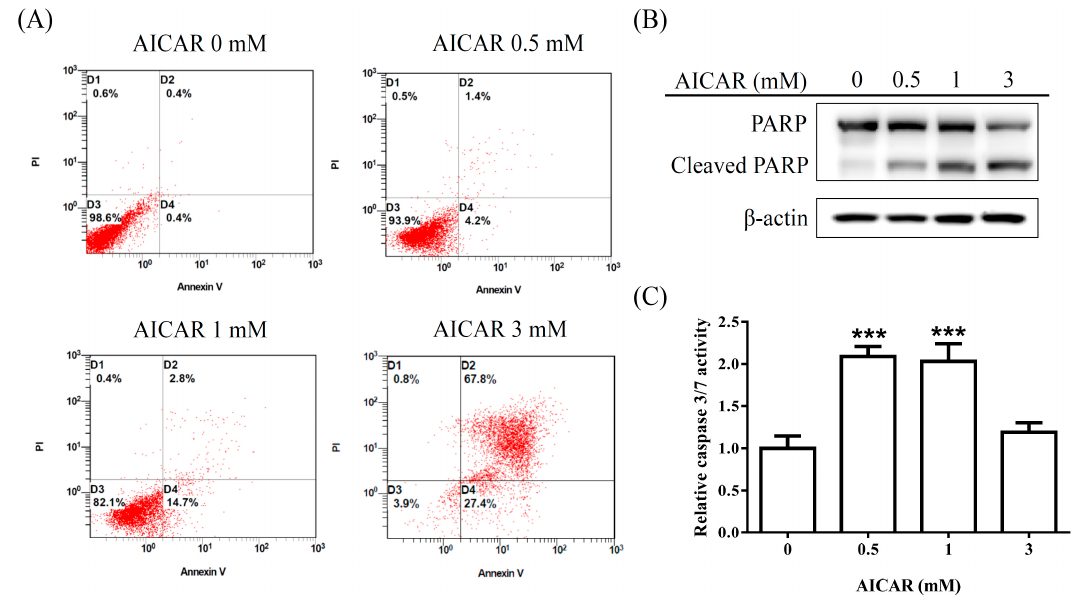
Figure 3. Effect of AICAR on the apoptosis in 22Rv1 prostate cancer cells. Cells were incubated with different concentrations of AICAR for 24 h. ( A ) Cells were collected, stained with Annexin V and propidium iodide (PI), and analyzed by flow cytometry. Data are representative of at least three independent experiments with similar results. ( B ) The expression of Poly(ADP-ribose) polymerase (PARP) was determined by western blot. Actin was used as a loading control in western blot. ( C ) Cellular caspase 3/7 activities were analyzed with caspase-glo assay kit. Data are represented as means ± SD of triplicate values and statistical significance was determined using the Student’s t-test (*** p < 0.001).